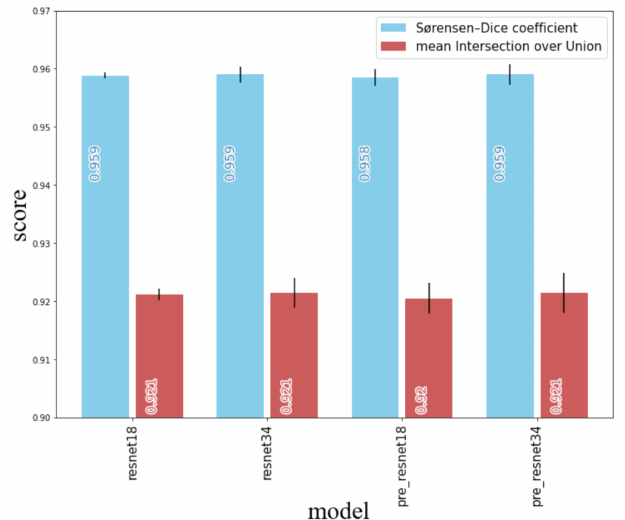
Figure 7. Sørensen–Dice (blue) coe ffi cient as well as mean intersection over union (red) for di ff erent pre-trained heads with and without data pre-processing (prefix “pre_”). Scores (rounded to third decimal point) are written into